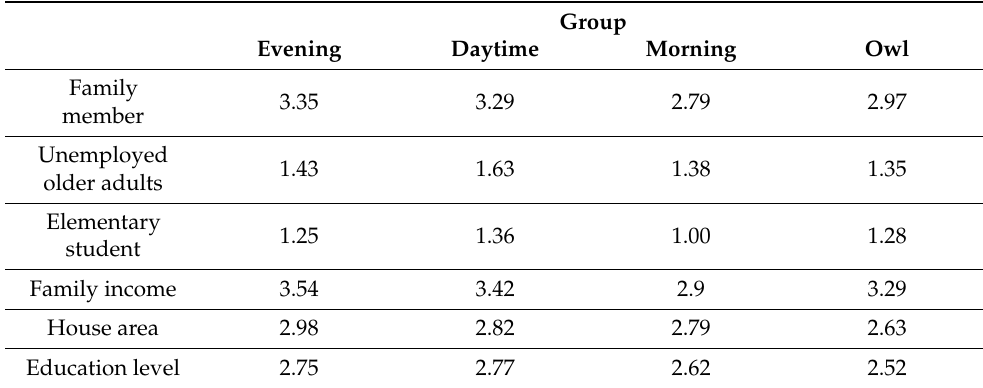
Table 4. Average of the demographic index by each